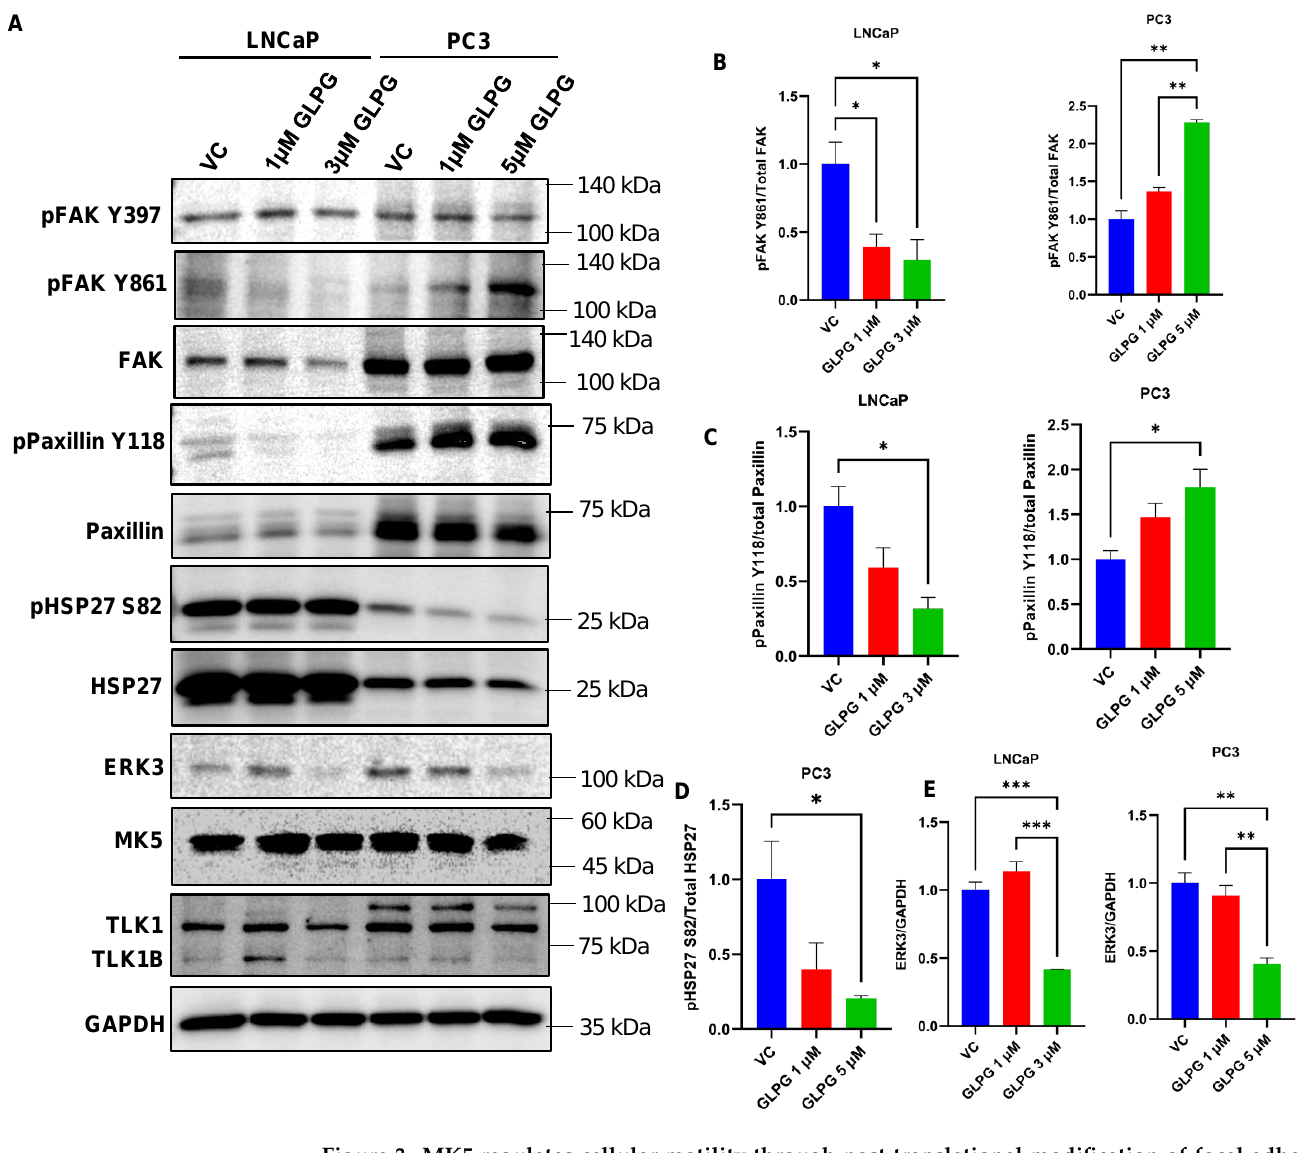
Figure 3. MK5 regulates cellular motility through post-translational modification of focal adhe- sion proteins and HSP27, as well as regulation of ERK3 stability in LNCaP and PC3 cells. ( A ) Im- munoblots of the indicated proteins in LNCaP and PC3 cells treated with different concentrations of GLPG0259. GAPDH was used as a loading control. Images are the representation of three in- dependent experiments ( n = 3). ( B – E ) Quantifications of ( B ) Phospho-FAK Y861 level normalized to total FAK; ( C ) Phospho-Paxillin Y118 level normalized to total paxillin; ( D ) Phospho-HSP27 S82 normalized to total HSP27; and ( E ) ERK3 level normalized to GAPDH in LNCaP and PC3 cells. VC = vehicle control (DMSO). One-way ANOVA, followed by Tukey’s post hoc analysis, was used for multiple group comparison. Groups which are significantly different from each other are marked by asterisks: * = p < 0.05, ** = p < 0.005, and *** = p < 0.0005. Error bar represents standard error of the mean (SEM). The whole blots of Figure 3 could be found in Figure